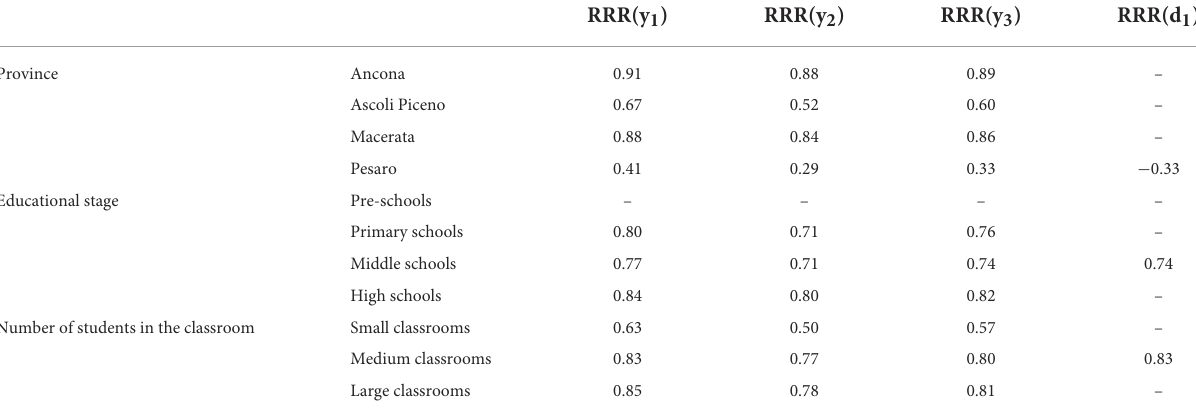
TABLE 3 Relative risk reduction (RRR) ratios for four indicators and 11